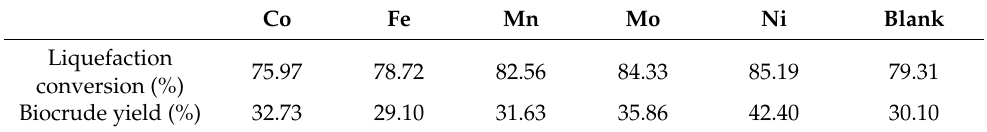
Table 6. Effect of transition metal/TiO 2 catalyst on liquefaction conversion and bio-crude yield [95]. Co